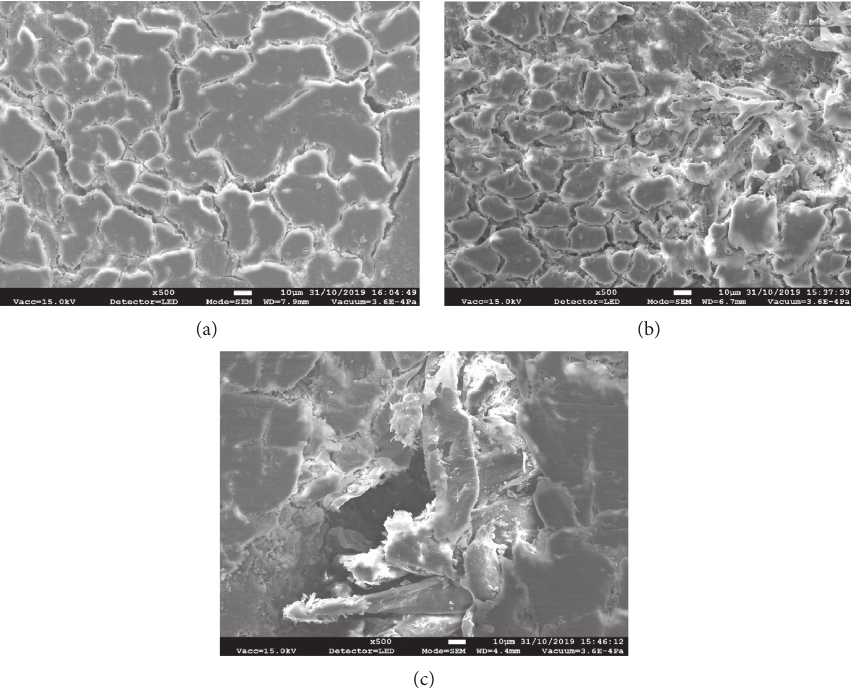
Figure 7: SEM micrographs of the cross sections of the flax/epoxy composite samples: (a) 0% RH, (b) 35% RH, and (c) 90% RH.